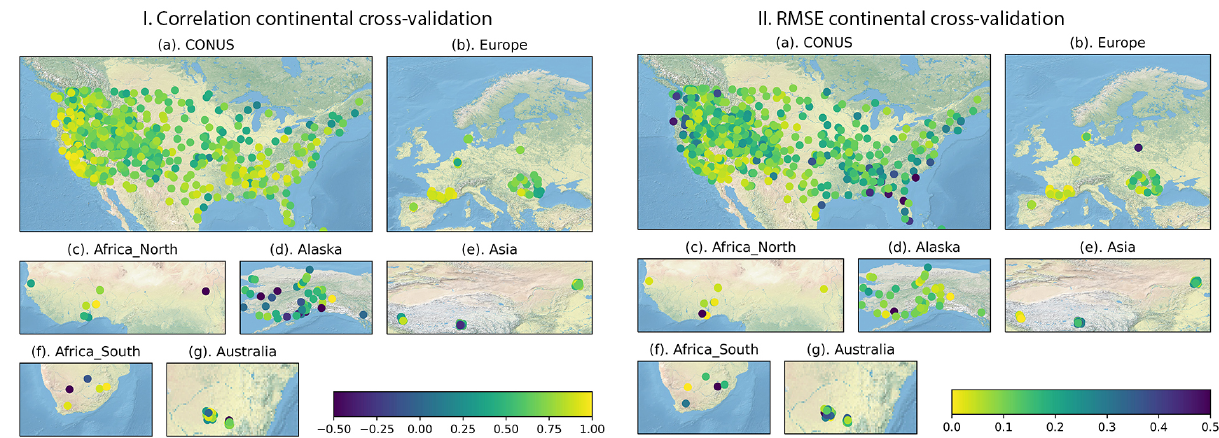
Figure 4. Metric distributions for the multitask model continental cross-validation tests. (I) Correlation and (II) RMSE of continental cross- validation tests for (a) the CONUS, (b) Europe, (c) Africa_North, (d) Alaska, (e) Asia, (f) Africa_South, and (g) Australia. The training and testing periods were both from 1 April 2015 to 31 December 2020. Maps are made with Natural Earth imagery, no permission needed (Natural Earth,